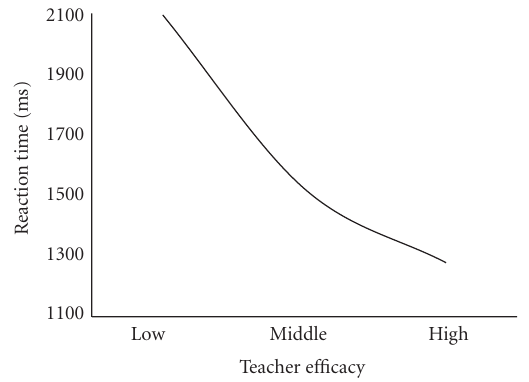
Figure 3: The relationship between updating information and teacher e ffi